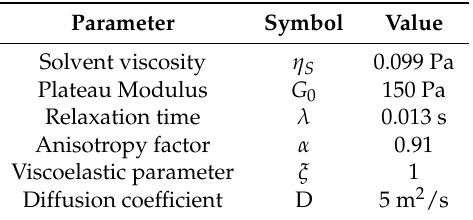
Table 1. Giesekus